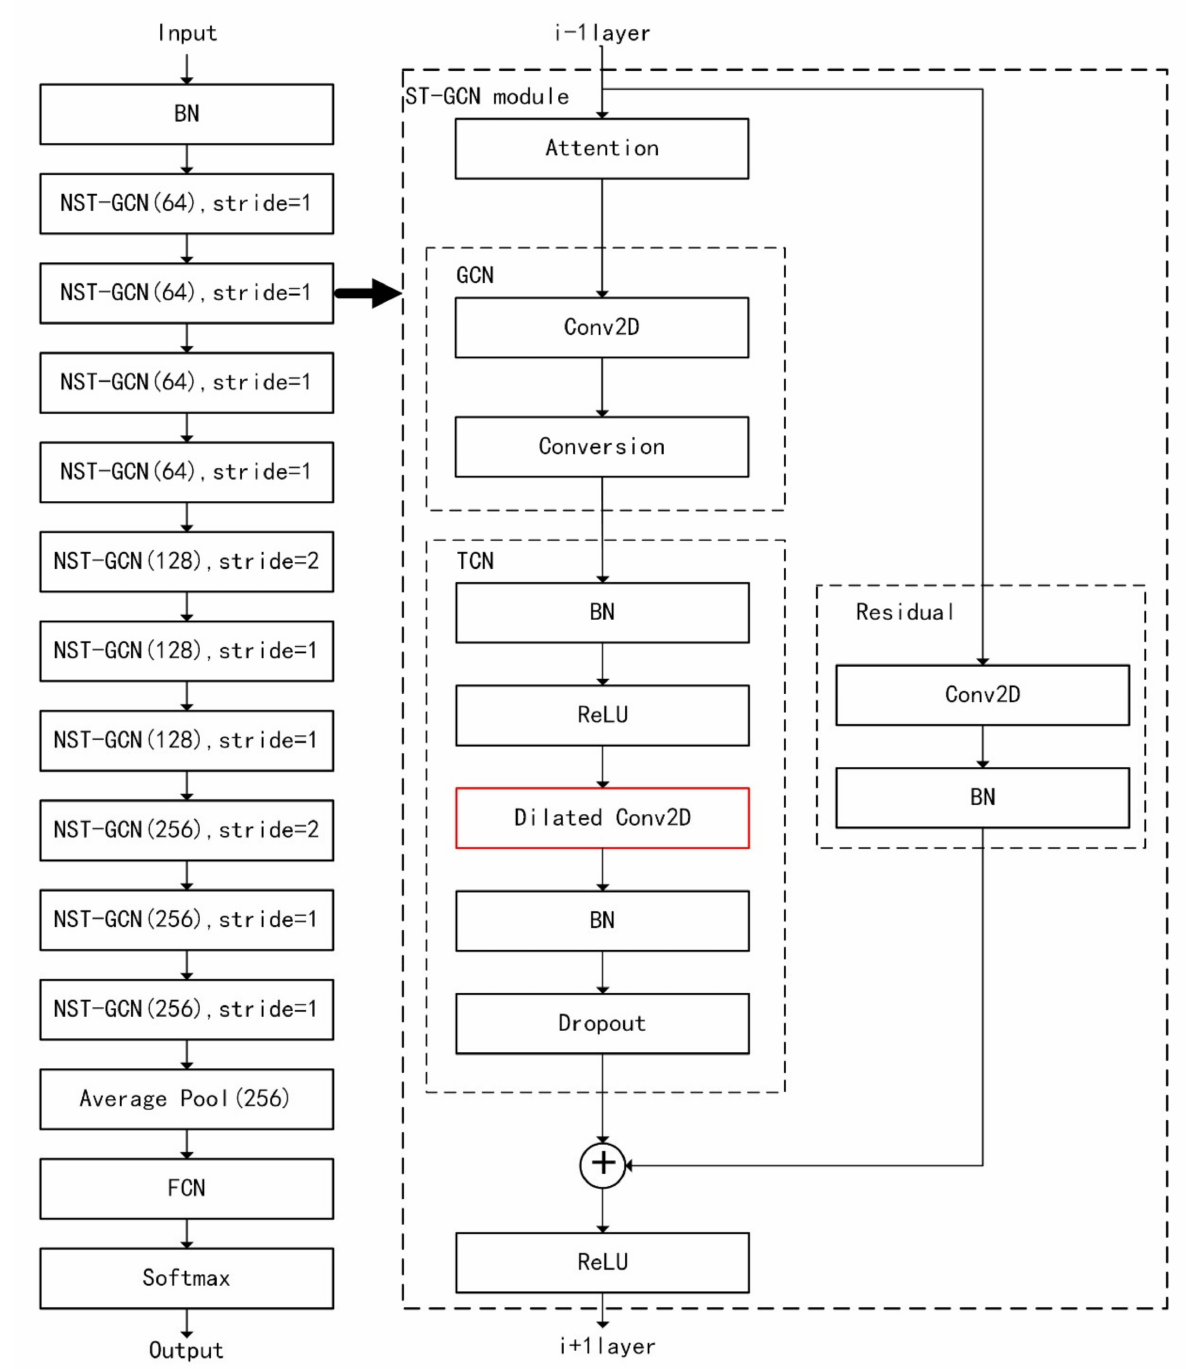
Figure 8. NST-GCN network